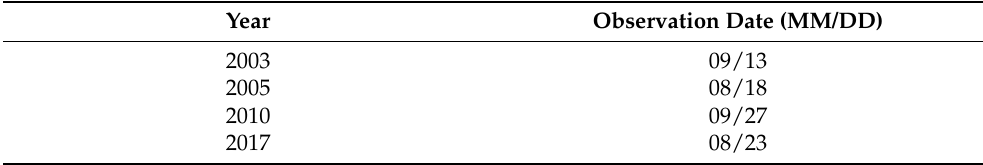
Table 2. Observation dates of the high-resolution images.